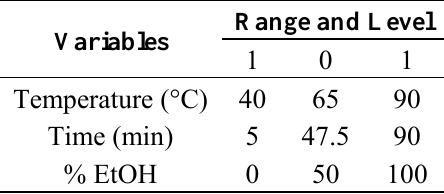
Table 1. Variables and ranges used on the experimental design for the study of temperature ( T ), time ( t ) and %